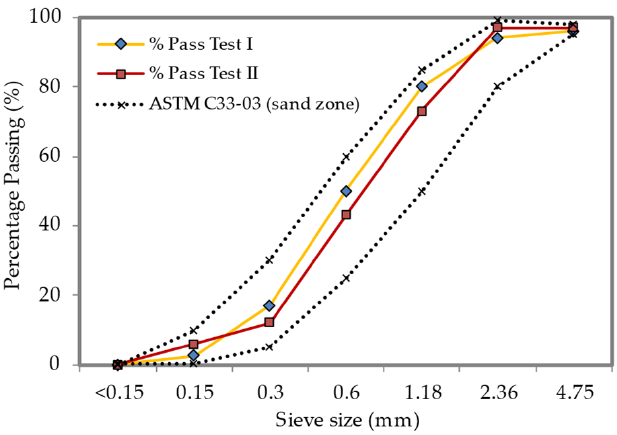
Figure 1. Sand grading curve of fine river sand with ASTM-C33 upper and lower limits.